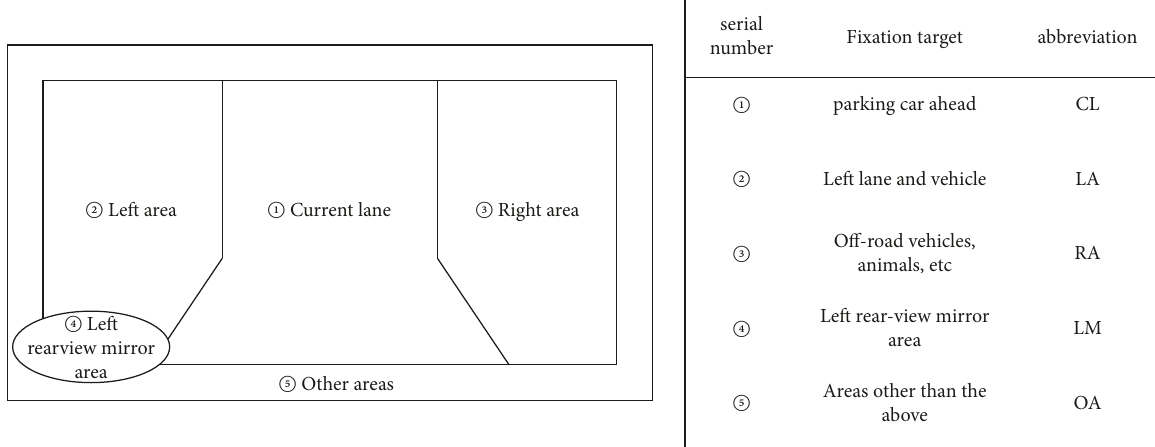
Figure 3: Division of area of interest.